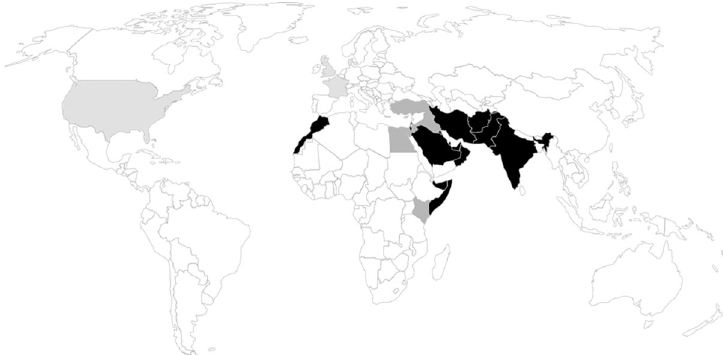
Fig 1. Geographical distribution of Rhinocladiella mackenziei cerebral phaeohyphomycosis ( N = 36). In black, countries with confirmed cases. In dark gray, countries with possible contamination. In light gray, countries where diagnoses were made but unlikely to be at risk for contamination (probable imported cases). If several countries were possibly incriminated, priority was given to the country with other confirmed cases if present; else, every country was considered as “possible contamination.” Articles used in this figure are reported in S1 Table . Map template can be found at